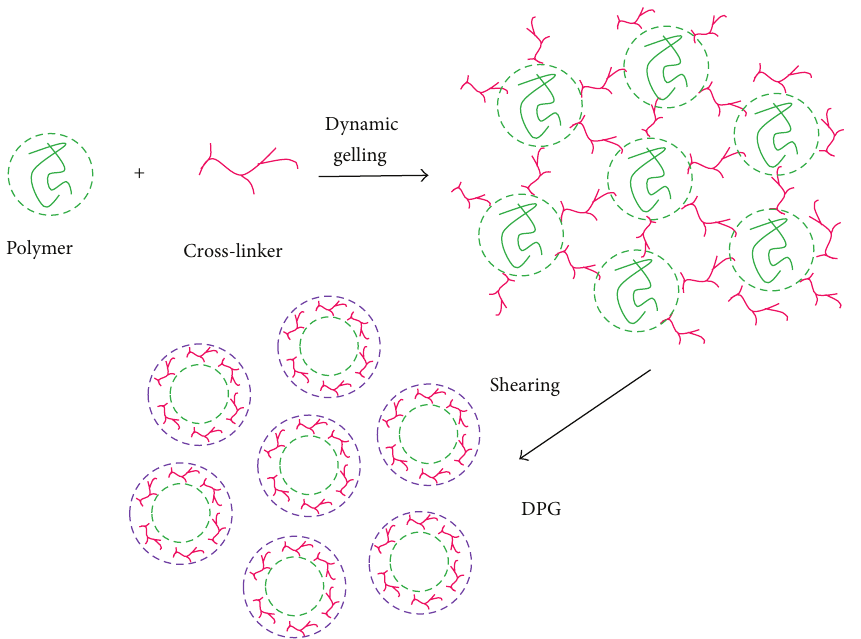
Figure 2: The proposed formation mechanism of DPG.